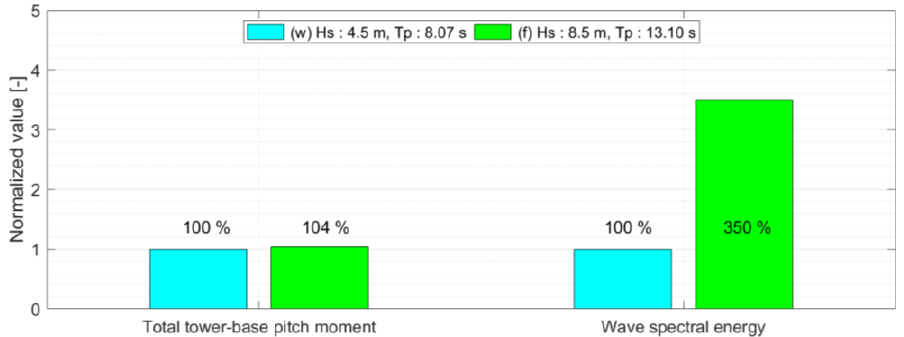
Figure 14. Normalized values of total tower-base pitch moments and wave spectral energy.